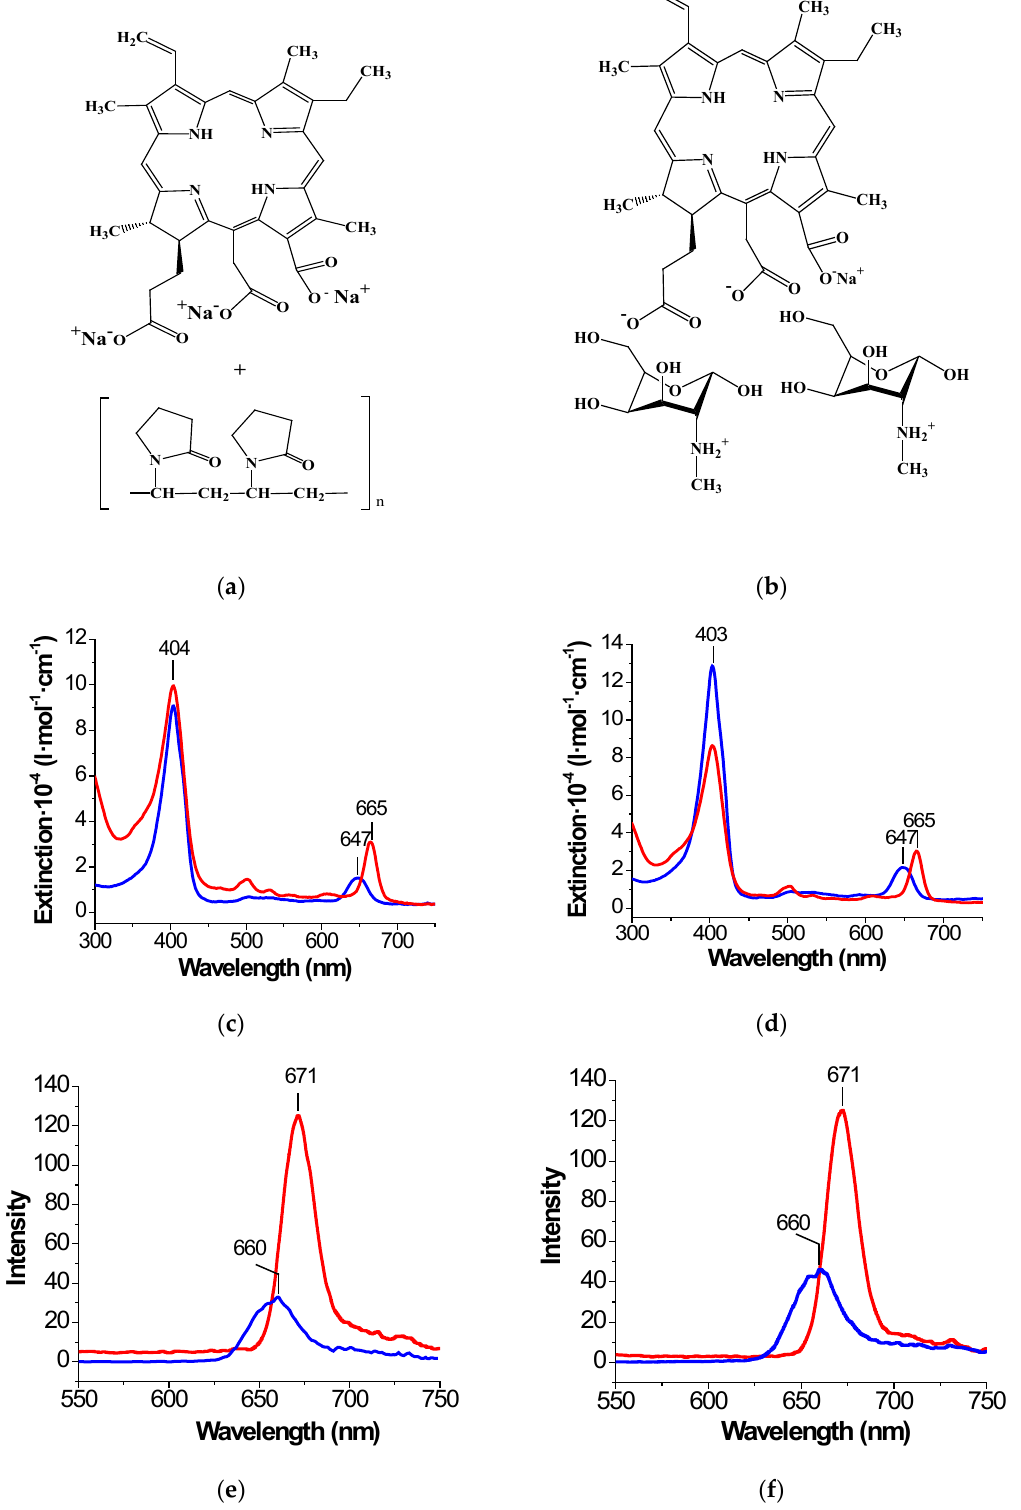
Figure 1. Molecular structures ( a , b ), absorption (( c , d ) ~ 1 × 10 –5 mol/kg), and fluorescence (( e , f ); ~ 1 × 10 –6 mol/kg) spectra of the PSs studied: ( a , c , e )—“Fotoran e 6 ” as a chlorin e 6 trisodium salt; ( b , d , f )—“Fotoditazin” as a dimeglumine sodium salt of chlorin e 6 . The blue lines show the results in water, while the red lines refer to liquid